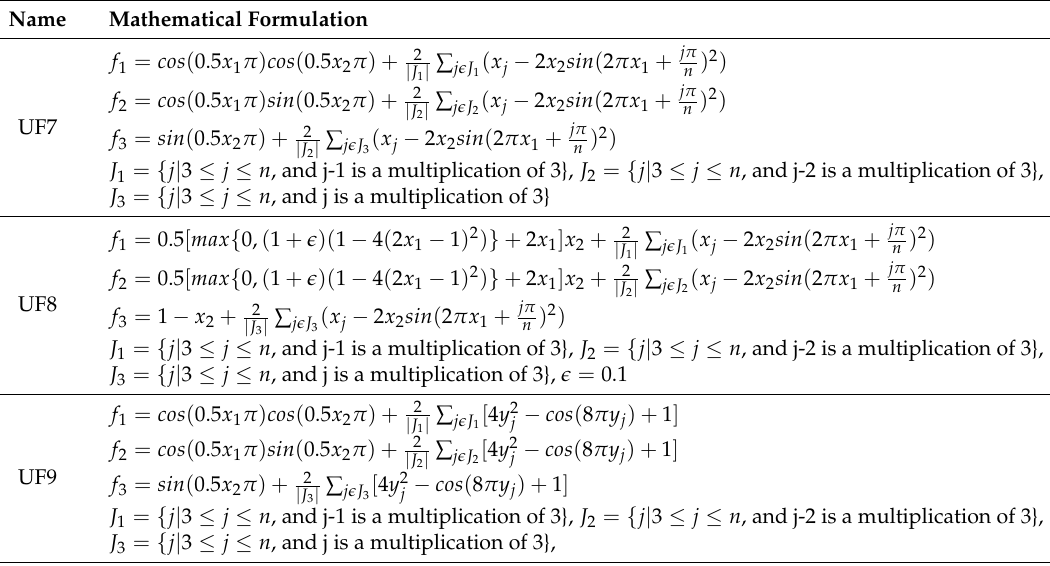
Table 3. Tri-objective benchmark